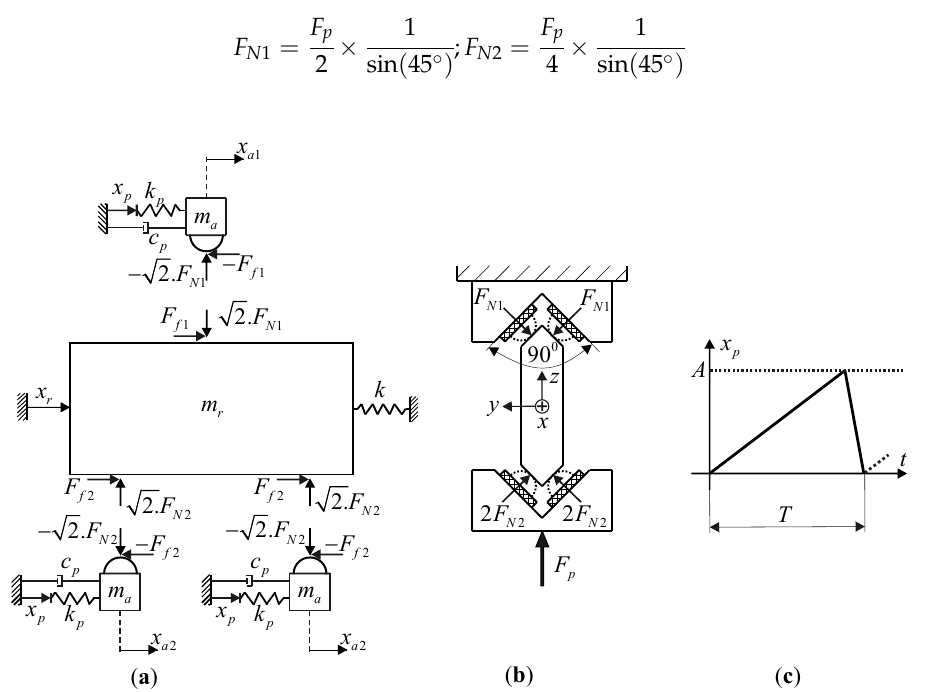
Figure 3. Macroscopic model for the investigated drive with six actuators: ( a ) front view with only √ three of six actuators represented (the factor 2 is added in front of F Nj ( j = 1,2) because of their projections in xz plane); ( b ) side view; ( c ) saw-tooth-like deformation of the